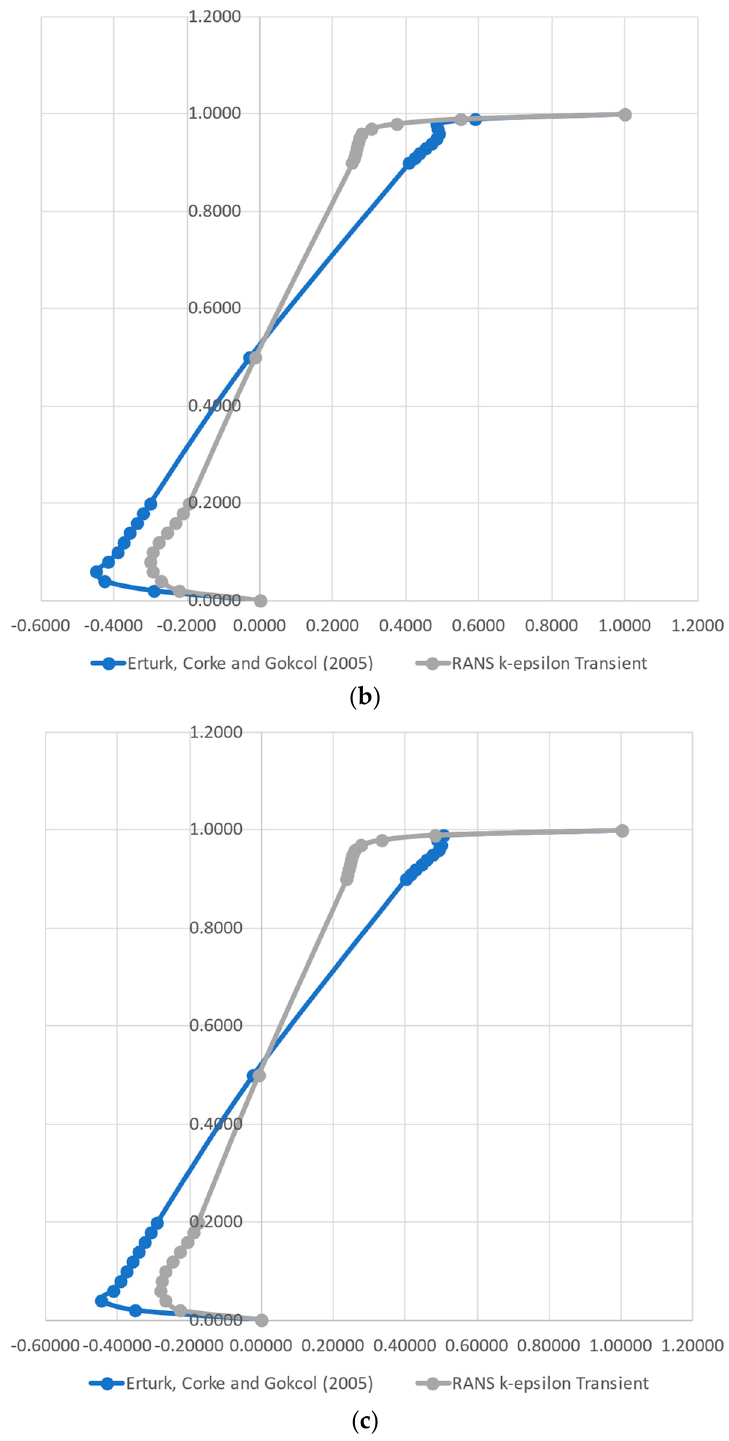
Figure 2. Comparison of the horizontal velocity component over a vertical line obtained by the CFD model (RANS k- ε ) and the reference values from [37] for the Reynolds numbers of 1000 ( a ), 10,000 ( b ) and 20,000 ( c ).